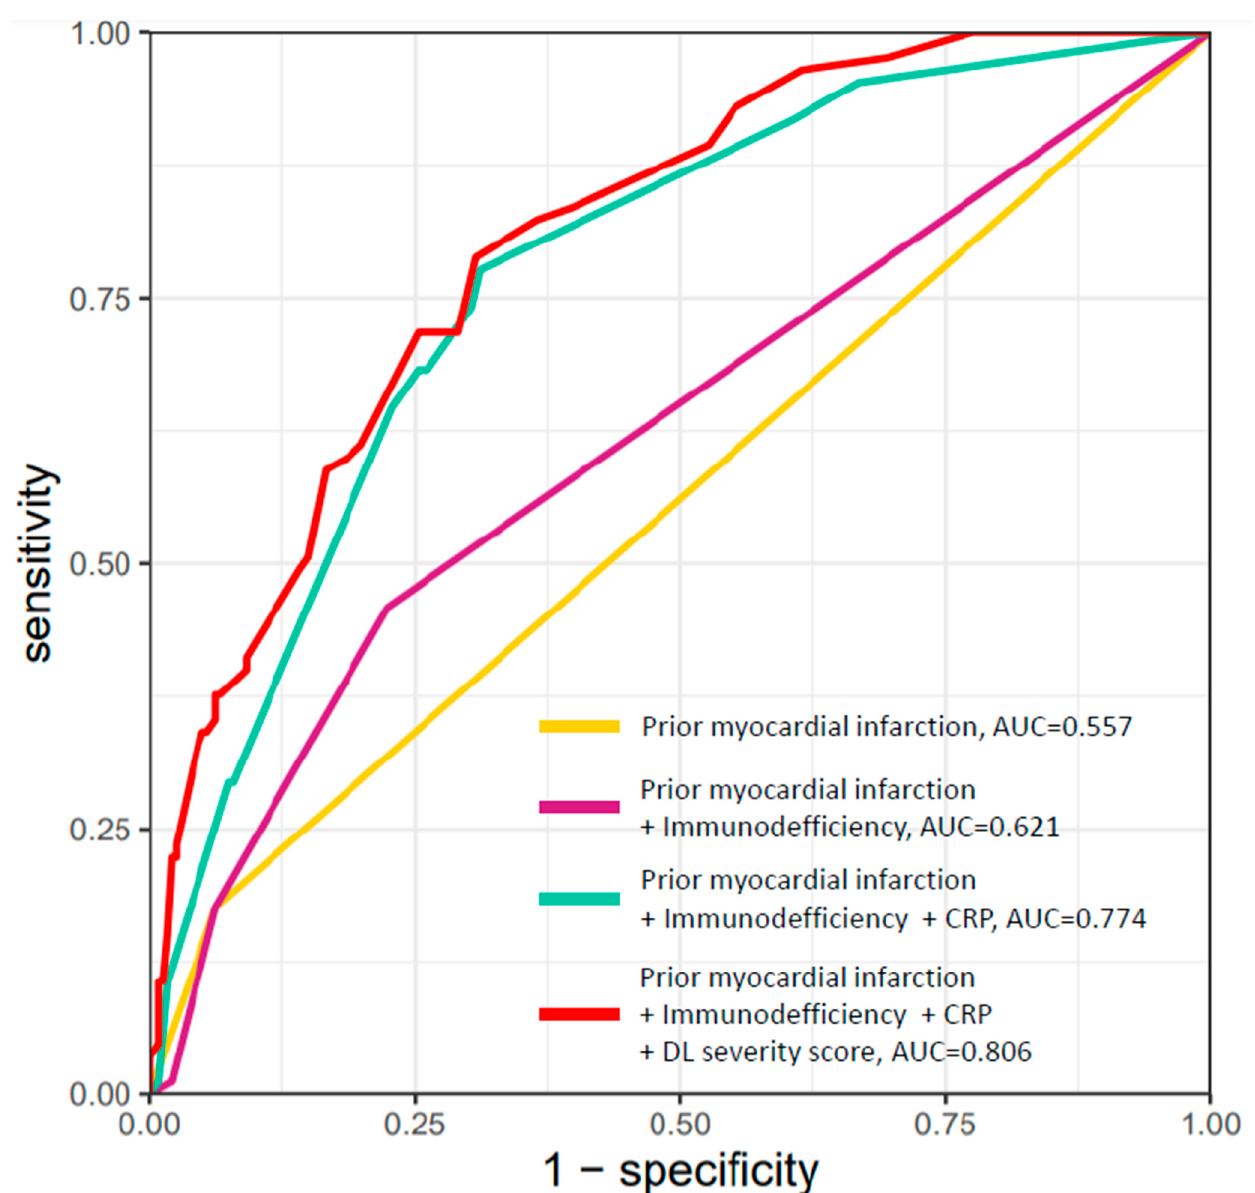
Figure A5. ROC analysis of combined predictors. Abbreviations: AUC = area under curve, CRP = C-reactive protein, DL = deep learning.